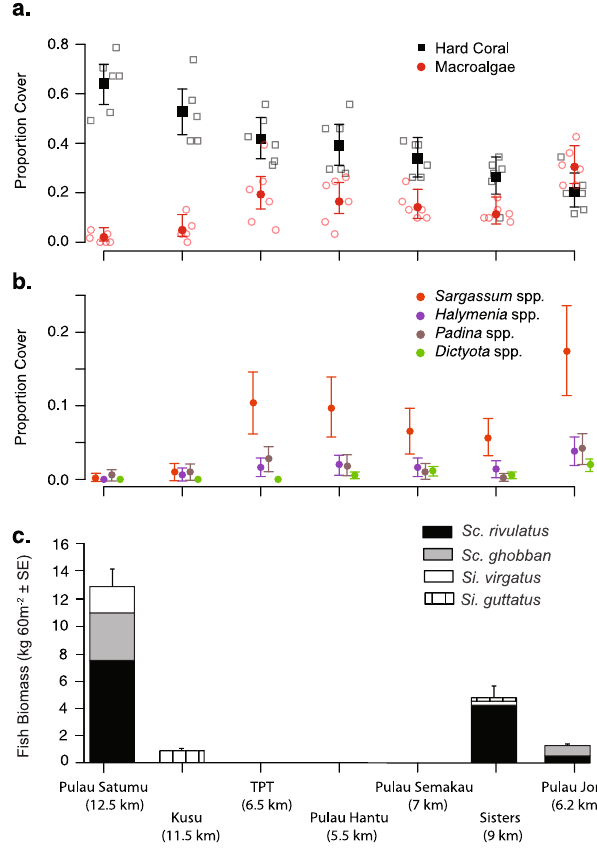
Figure 2. Variation in the proportion of hard coral and macroalgal benthic cover at each reef, ranked by proportion of hard coral cover along the x-axis (decreasing left to right), and browsing fish biomass among reefs in Singapore. ( a ) Raw data (open symbols) and model fits (filled symbols ± 95% CI) from separate binomial GLM’s for hard coral and macroalgae cover. ( b ) Model fit ( ± 95% CI) from multivariate model of macroalgae genera point-intercept counts per transect, presented as proportion cover. Estimates from macoalgae genera with significant differences between reefs are presented. ( c ) Macroalgal browser biomass estimates for each reef based on six 30 × 2-m belt transects. Distance (km) from the main port is presented in